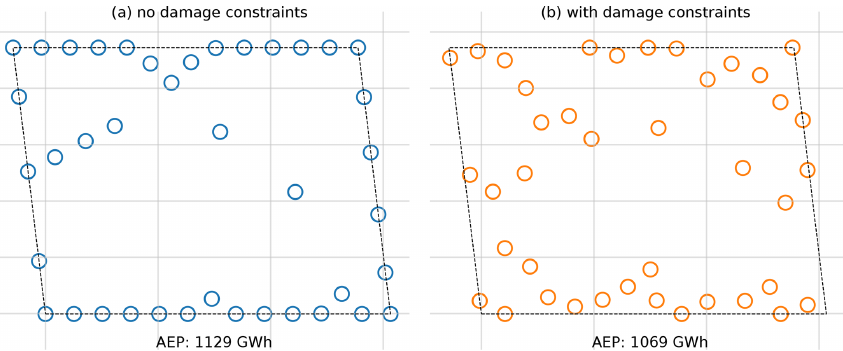
Figure 15. The optimal layout results from our optimization. On the left are (a) the optimal turbine locations when the turbine layout is optimized without damage constraints. On the right are (b) the turbine locations when damage from partial waking is constrained to be less than 0.04. The dotted black lines represent the wind farm boundary, and the circles represent the wind turbines, with the circle diameter accurately scaled to represent the turbine rotor diameter.